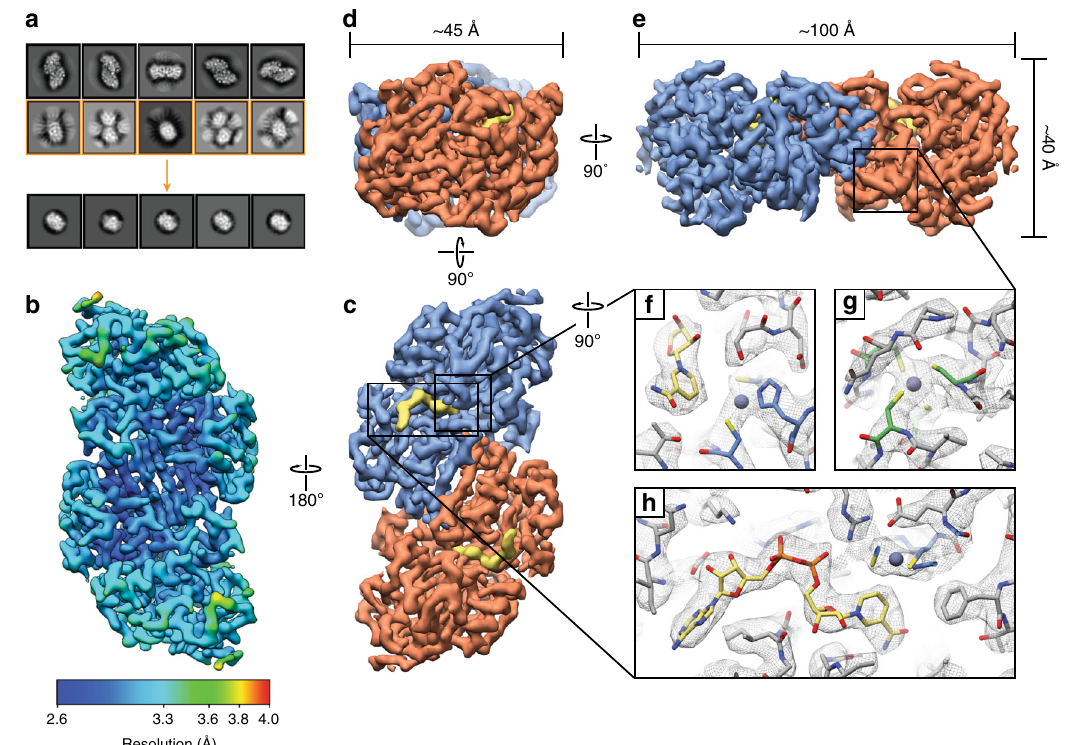
Fig. 1 2.7 Å resolution cryo-EM reconstruction of 82 kDa horse liver alcohol dehydrogenase. a Representative reference-free 2D class averages of horse liver alcohol dehydrogenase (ADH). Particles comprising the 2D classes highlighted in yellow were subsequently further classi fi ed using a smaller soft circular mask (see methods). b Final cryo-EM reconstruction colored by estimated local resolution estimated with BSOFT 23 . c - e Orthogonal views of the ADH EM density (colored by subunit) showing the disparity in particle dimensions. The segmented NADH EM density is shown in yellow. f – h Zoomed-in views of the EM density (gray mesh) for the ADH active-site zinc, structural zinc site, and active site, respectively. Residues involved in coordinating the active-site zinc (blue), the structural site zinc (green) or interacting with NADH (yellow) are shown in stick representation. The zinc atoms are shown as purple